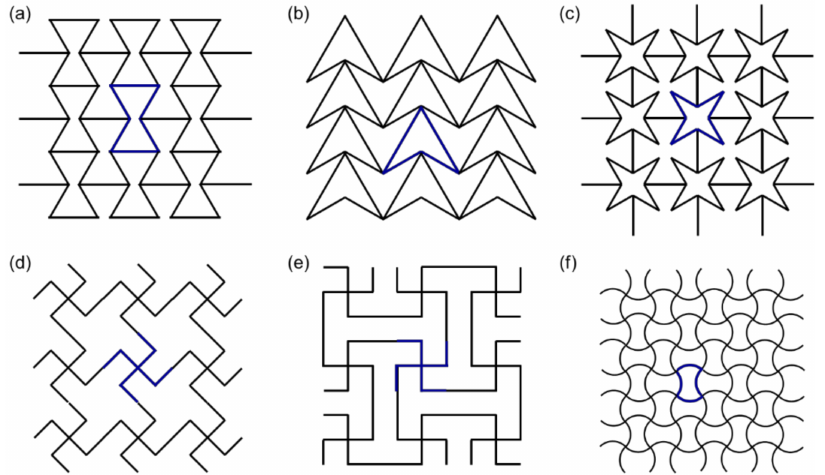
Figure 2. Re-entrant structures. ( a ) Re-entrant honeycomb, ( b ) double arrowhead, ( c ) star honeycomb, ( d ) structurally hexagonal re-entrant honeycomb, ( e ) lozenge grids, ( f ) sinusoidal ligaments